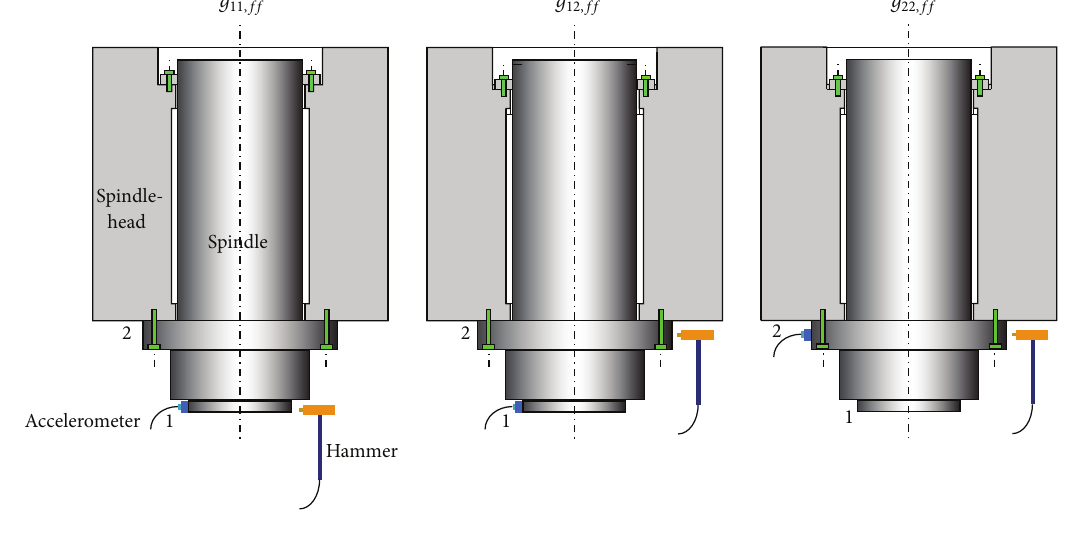
Figure 4: The schematic diagram of the spindle modal test.